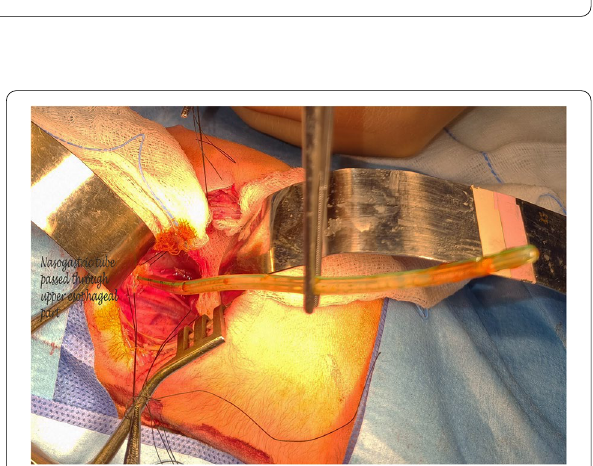
Fig. 4 CT chest with IV contrast; A coronal section and B horizontal section